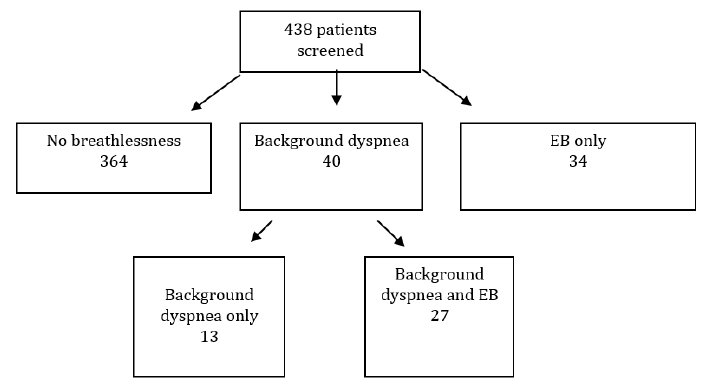
Figure 1. Flow chart of patients’ distribution. EB = episodic breathlessness.